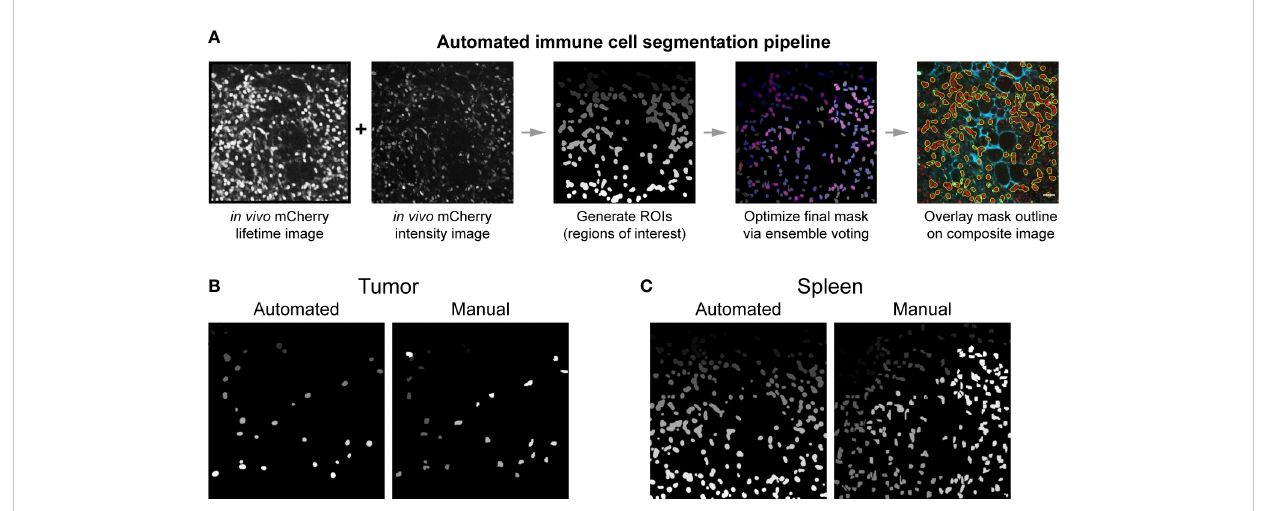
FIGURE 4 Automated immune cell segmentation pipeline to analyze in vivo multiphoton optical metabolic images. (A) Flowchart showing automated segmentation pipeline analysis on a single example image for mCherry-expressing immune cells. Pipeline developed in Python. This pipeline enables the extraction of metabolic data from each immune cell. (B, C) Representative examples of the comparison between an automated segmentation mask versus a manual segmentation mask of immune cells in a (B) B78 tumor (Mouse 2 FOV 7) and (C) spleen (Mouse 1 FOV6) fi eld of view. Dice coef fi cient scores were also calculated to show quantitative accuracy between automated masks and manual masks, as shown in Table S1. All fi elds of view (FOV) 300 × 300 m